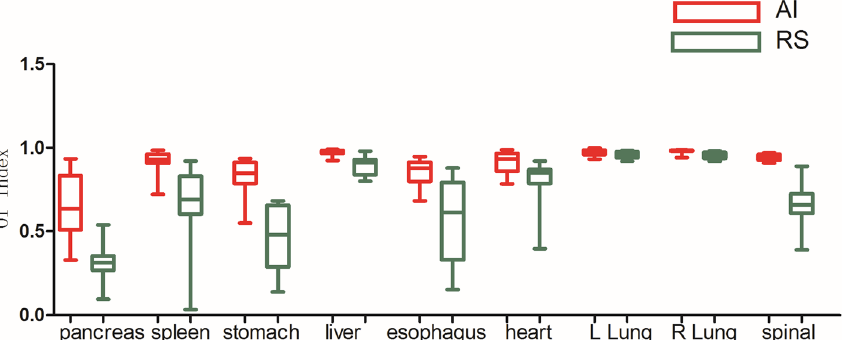
Figure 6. Comparison results of OI between two software in automatic delineation of lung cancer OAR.